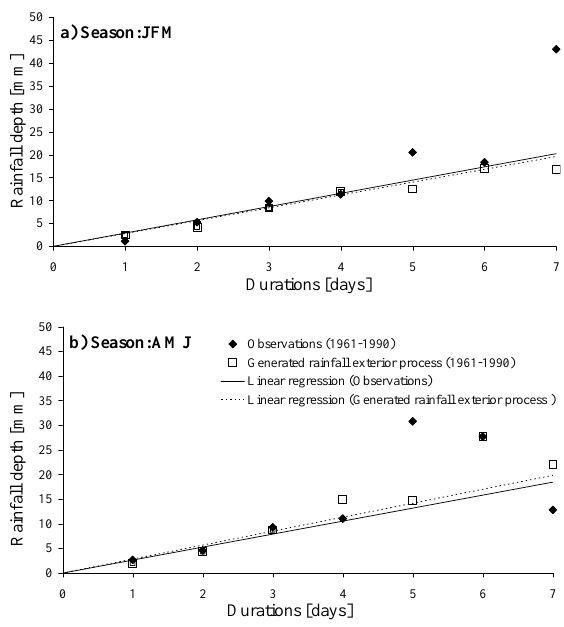
Fig. 9. Average DDF curves relative to cell #4 for observed data (solid line) and generated rainfall exterior process (dotted line) for winter (a) and spring (b) . The linear interpolations are based on the hypothesis of a maximum duration of single storms of less than five days.